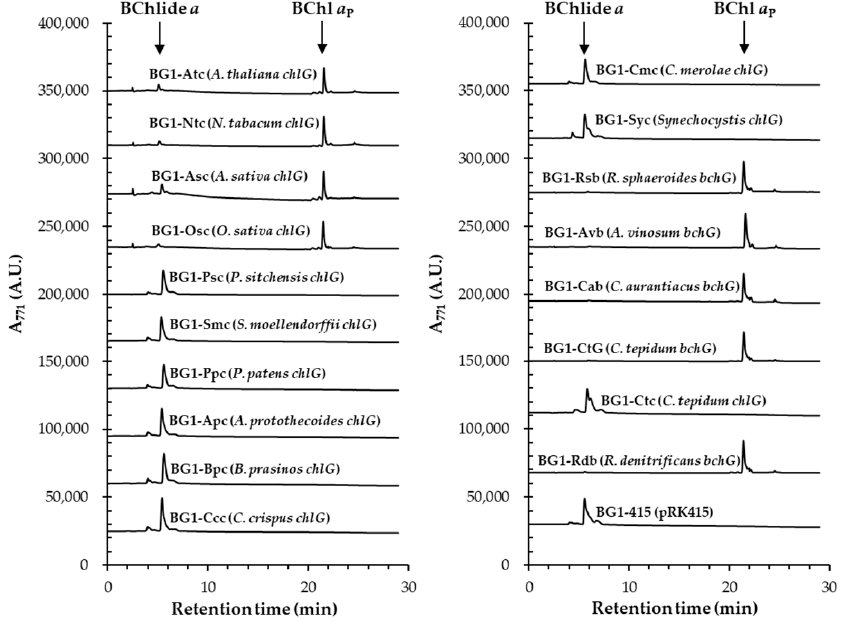
Figure 2. Formation of BChl a P in BG1 expressing bchG s and chlG s from various PS organisms. BG1 cells expressing bchG s and chlG s were cultured in the dark with 75 mM DMSO for seven days. Total pigments were extracted from the cells and subjected to HPLC analysis. BChlide a and BChl a P are indicated by arrows, which were detected by absorbance at 771 nm. A.U., Arbitrary